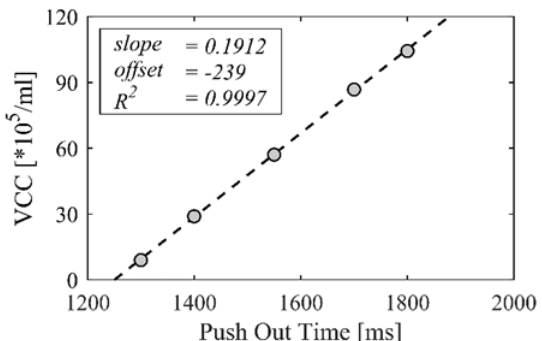
Figure 8. The required POT of the Numera filtration in dependency of the VCC in order to obtain 1.2 mL filtered culture supernatant was assessed experimentally. The linear relationship allows adaptation of the POT during the process to keep the received sample volume constant.